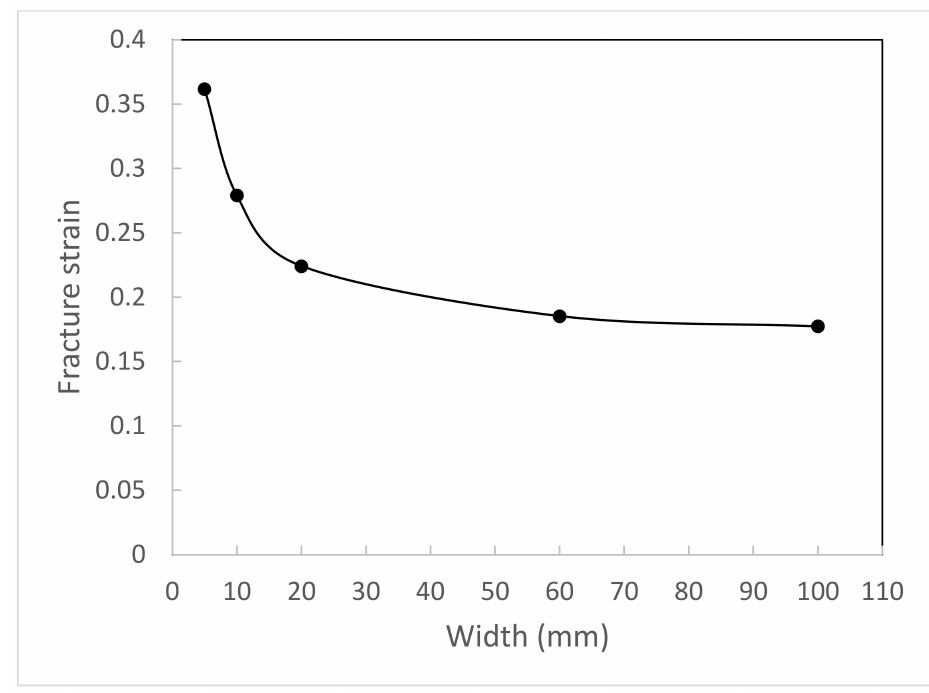
Figure 11. Fracture bending strain in metal sheets with various widths.